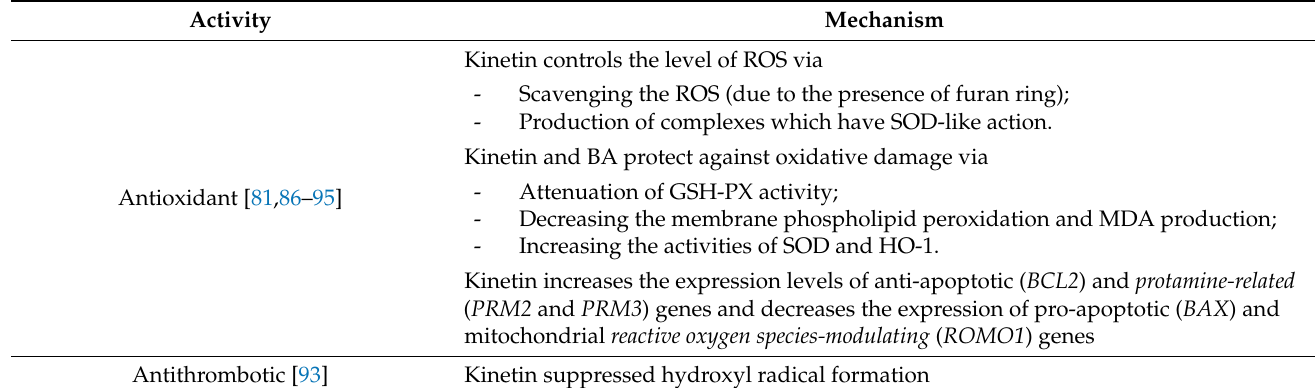
Table 1. Summary of the different pharmacological activities and the responsible mechanisms for